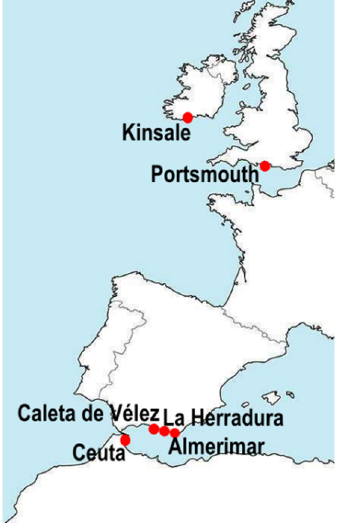
Figure 5. Viewpoints of the watershed depending on the distribution of the pontoons and boats, La Herradura (Granada) and Ceuta, ES.